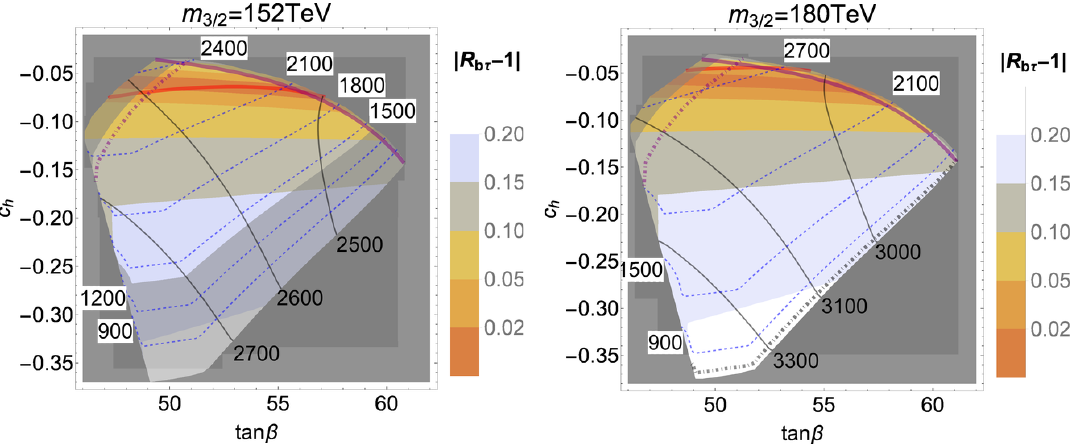
Figure 5 . Contours of j R b(cid:28) (cid:0) 1 j for m = 152 TeV (left) and 180 TeV (right). The black solid 3 = 2 (dashed) contours represent the mass of the lightest (heaviest) squark in the (cid:12)rst two generation in units of GeV. Above the red solid line the muon g (cid:0) 2 anomaly is explained within the 2 (cid:27) level.